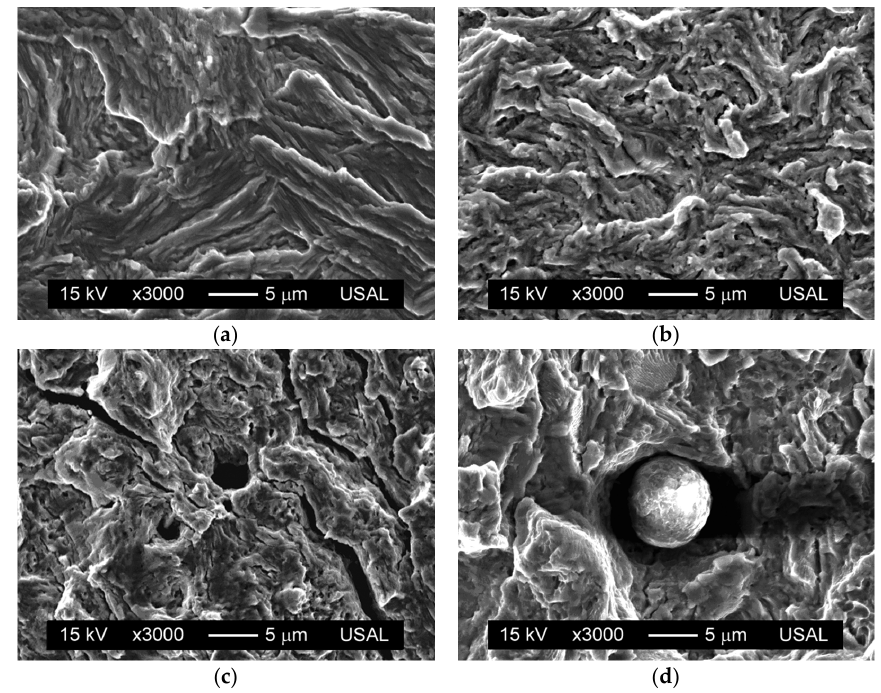
Figure 2. Fatigue fracture surface: ( a ) hot rolled bar, Δ K = 23 MPam 1/2 ; ( b ) cold drawn wire, Δ K = 27 MPam 1/2 ; ( c ) micro ‐ cracking, Δ K = 42 MPam 1/2 ; ( d ) particle, Δ K = 34 MPam 1/2 .